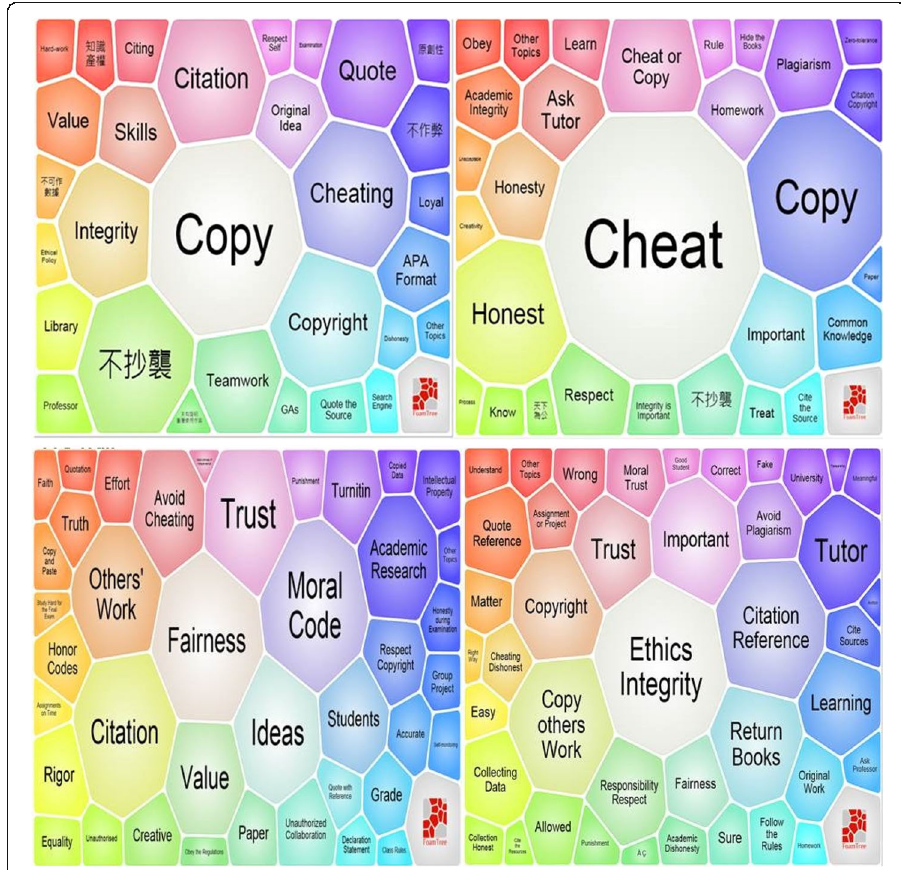
Fig. 4 Pre- (left) and post- (right) trail text comparison (TIE-General). (Top) First year UG students at orientation ( n = 90). (Bottom) Year 3 Business major students ( n =